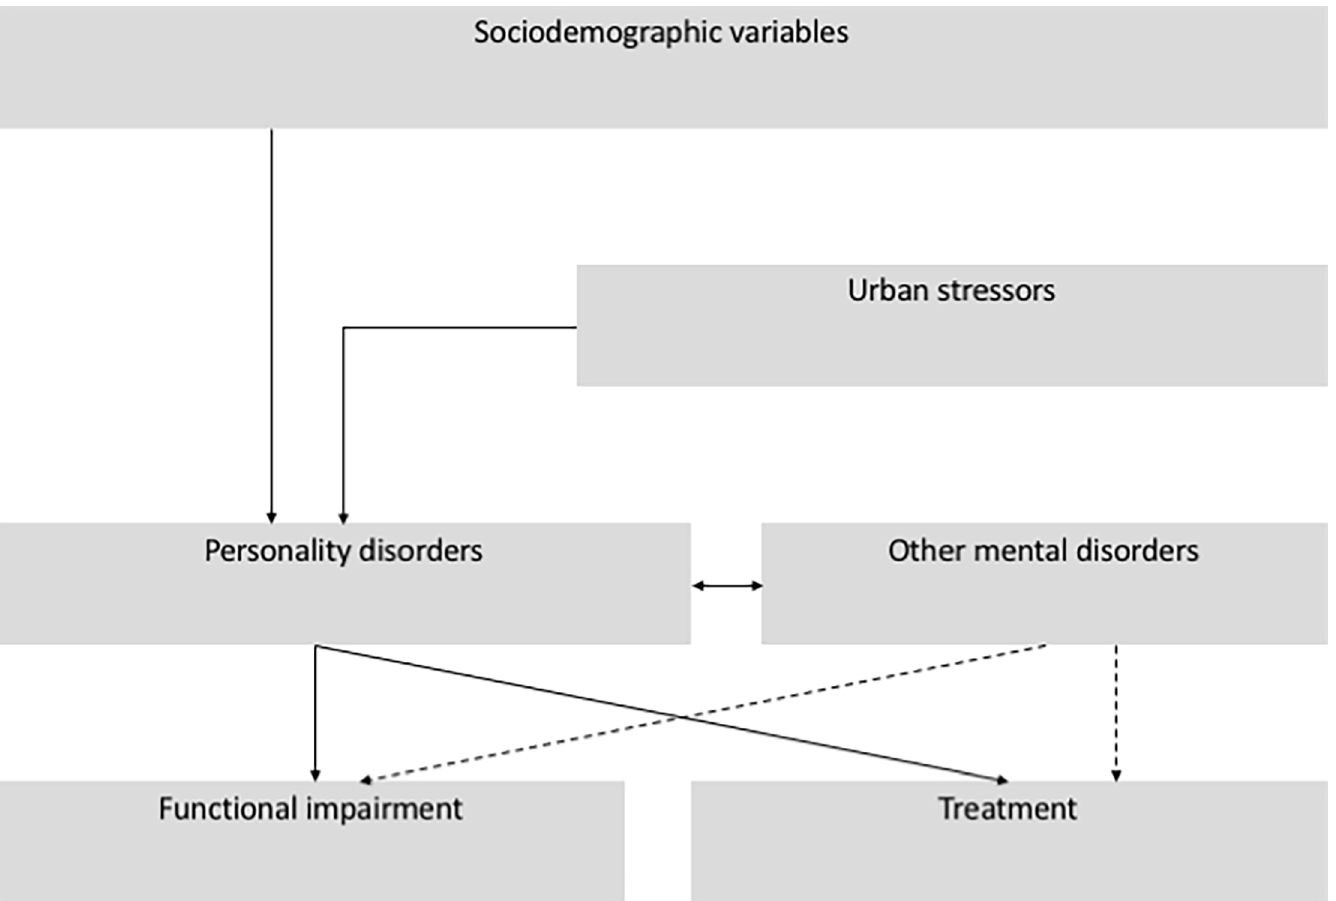
Fig 1. Conceptual framework of the